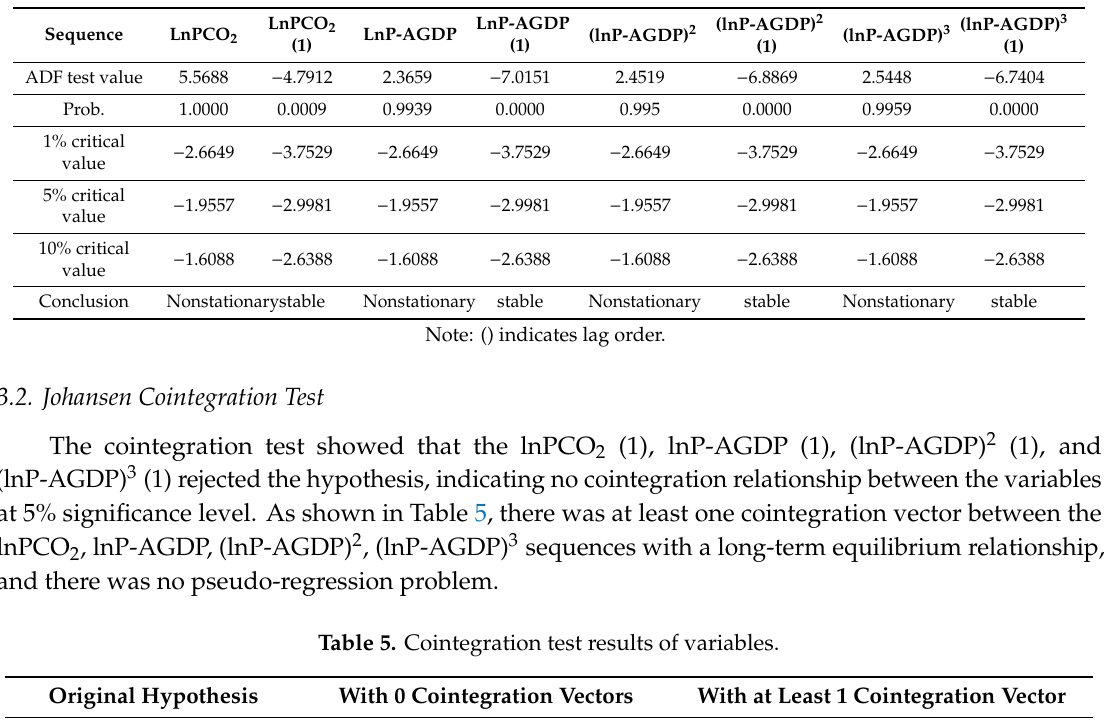
Table 4. Unit root test results.